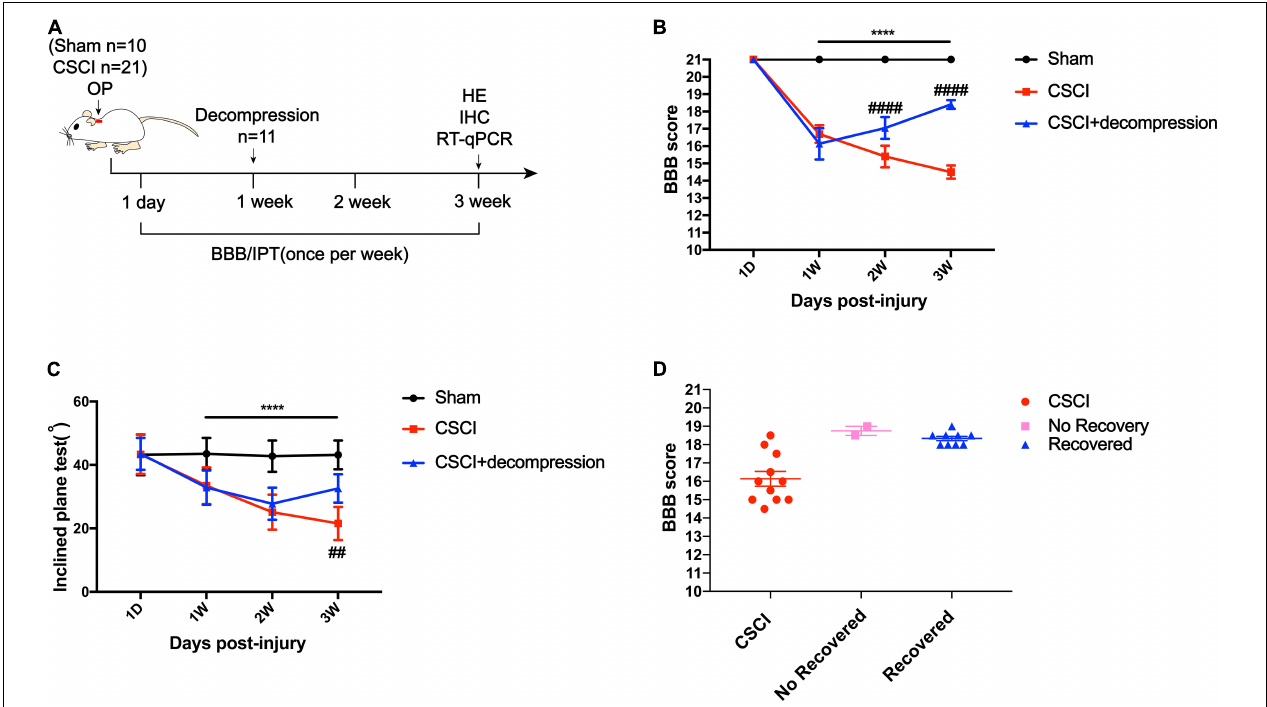
FIGURE 2 | Early decompression promoted motor function recovery after CSCI. (A) Experimental design. (B) Animals were tested weekly starting from 1 dpi in an open field, and motor function recovery was evaluated according to the BBB score [Two-way ANOVA, F (1,8) = 66.13, p = 0.0043; **** p < 0.0001: sham group vs. CSCI group; #### p < 0.0001: CSCI group vs. CSCI with decompression group]. (C) Animals were tested weekly starting from 1 dpi using the IPT, and the angle ( ◦ ) was recorded to reveal motor function recovery [Two-way ANOVA, F (6,112) = 4.861, p < 0.001; **** p < 0.0001: sham group vs. CSCI group; ## p = 0.0052: CSCI group vs. CSCI with decompression group]. (D) BBB scores for recovered and non-recovery rats after decompression at 3 wpi. The Sham group: n = 10; CSCI group: n = 10; CSCI with decompression group: n = 11. df: the degrees of freedom; Mean ± 95% CI.